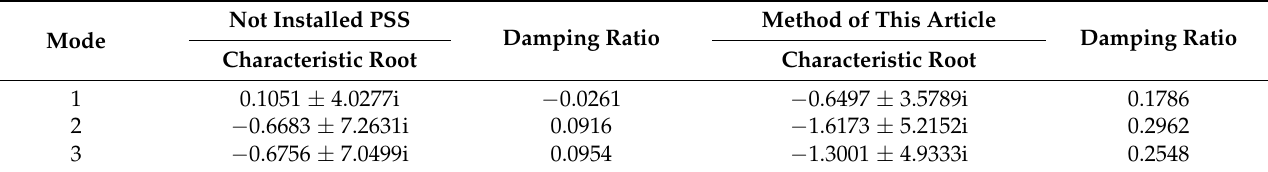
Table 6. System characteristic root and damping without and with PSS installed.